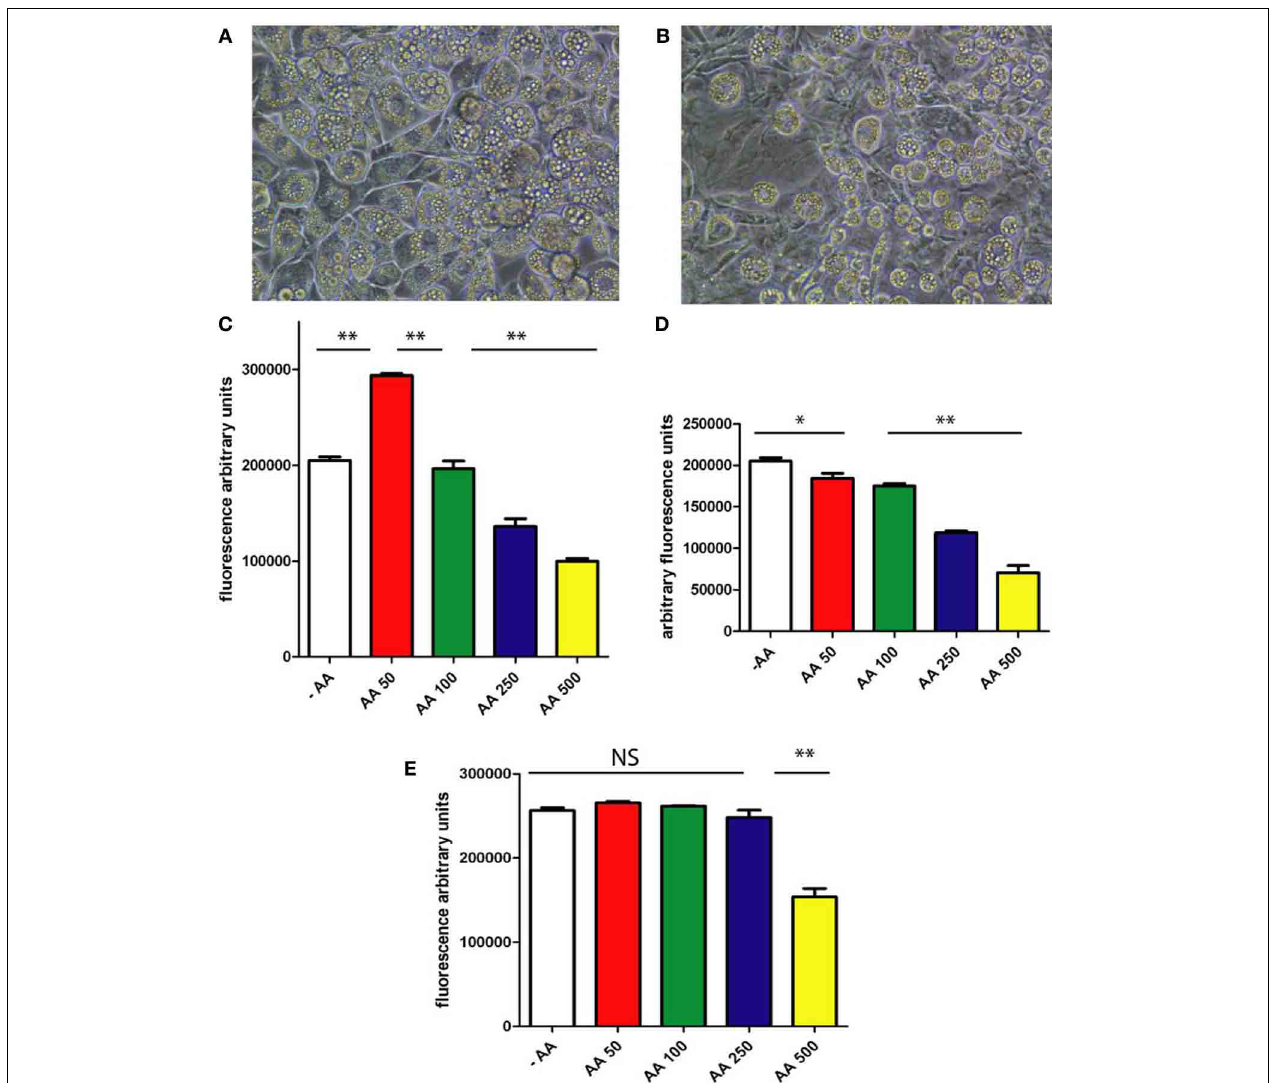
FIGURE 1 | 3T3L1 differentiation. Cells were cultured, with IBMX, during 9 days without AA (A) or with 0.5mM of AA (B) . After 9 days cells are stained with Oil Red O. (C) In an independent experiment 3T3L1 cells were treated with IBMX during 3 days and cultured without AA and with increasing doses of AA during a total of 9 days. At the end, AdipoRed is added and fluorescence recorded (for details see Materials and Methods). Results are expressed in fluorescence arbitrary units. (D) Cells were treated during 3 days with IBMX and with increasing doses of AA. Cells were then allowed to